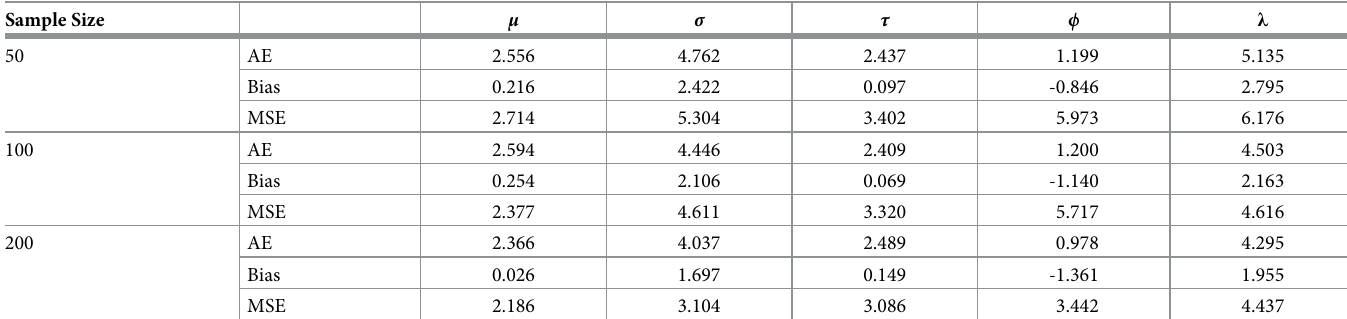
Table 3. Simulation result of MBTED(3,3,3.5,0.2,2). Sample Size